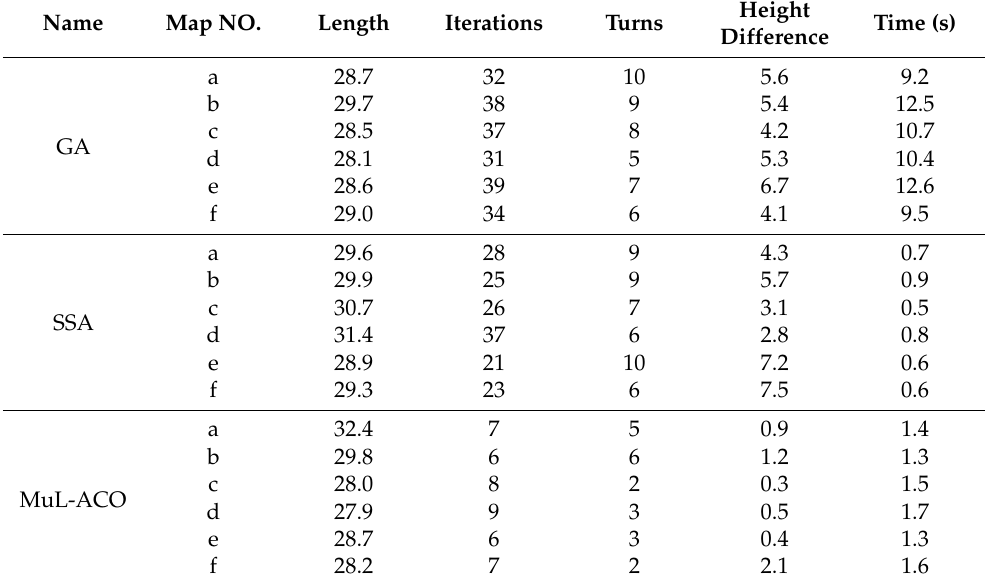
Table 2. Simulation results of GA, SSA, and